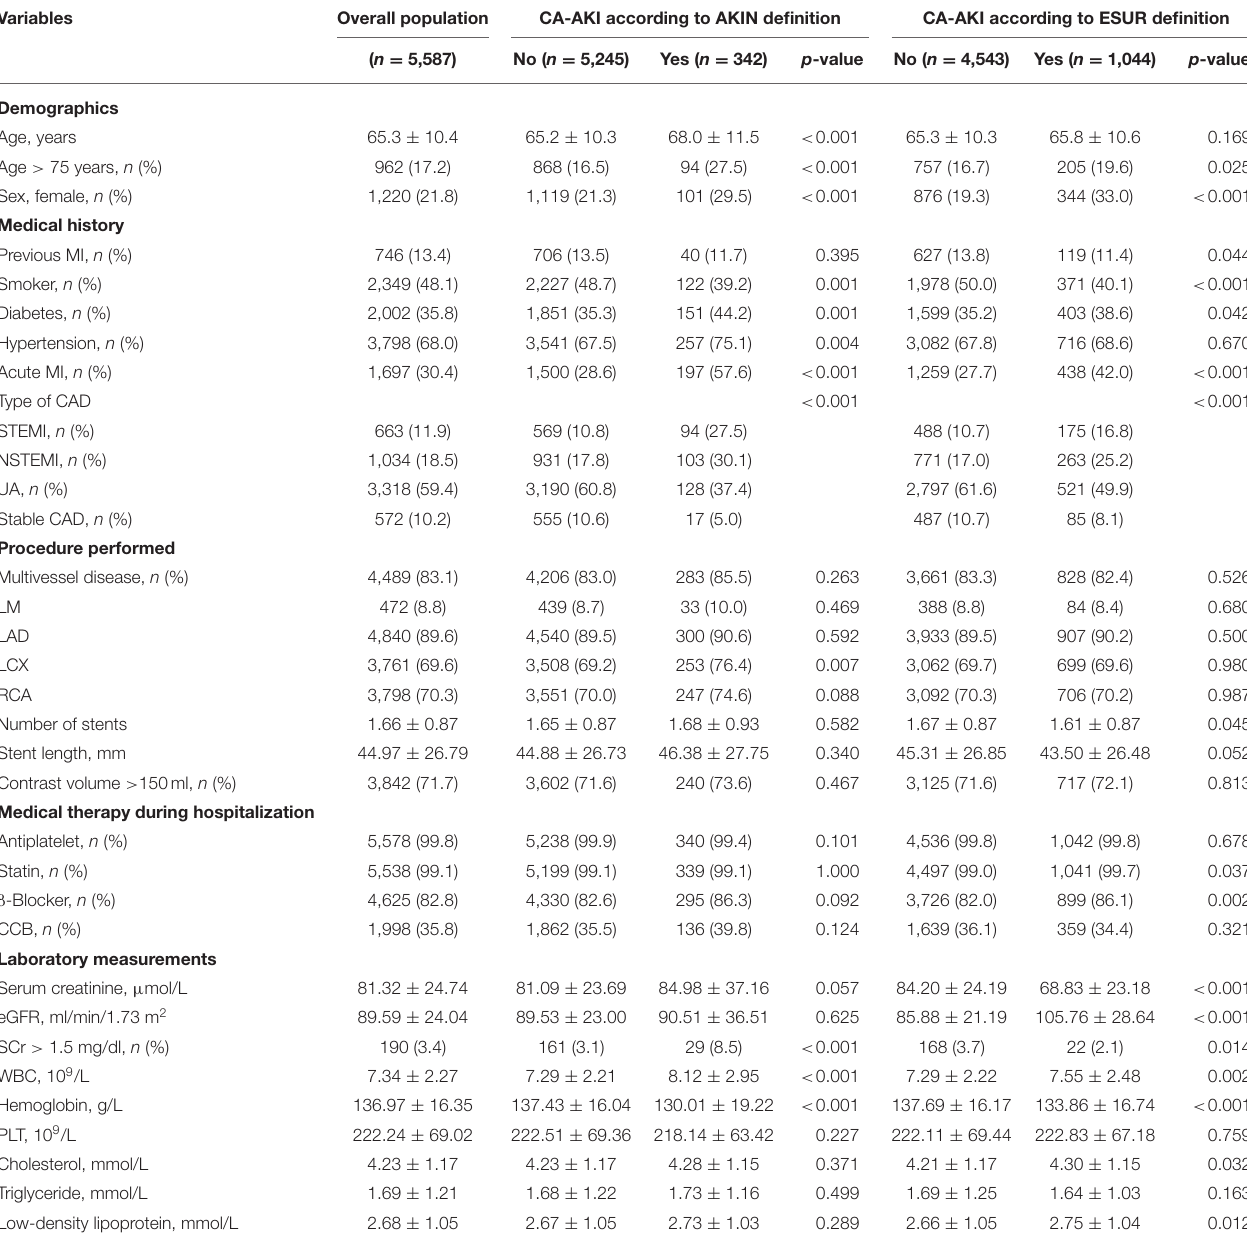
TABLE 1 | Comparison of baseline characteristics in the overall population and in those with CA-AKI according to both AKIN and ESUR definitions. Variables Overall population CA-AKI according to AKIN definition